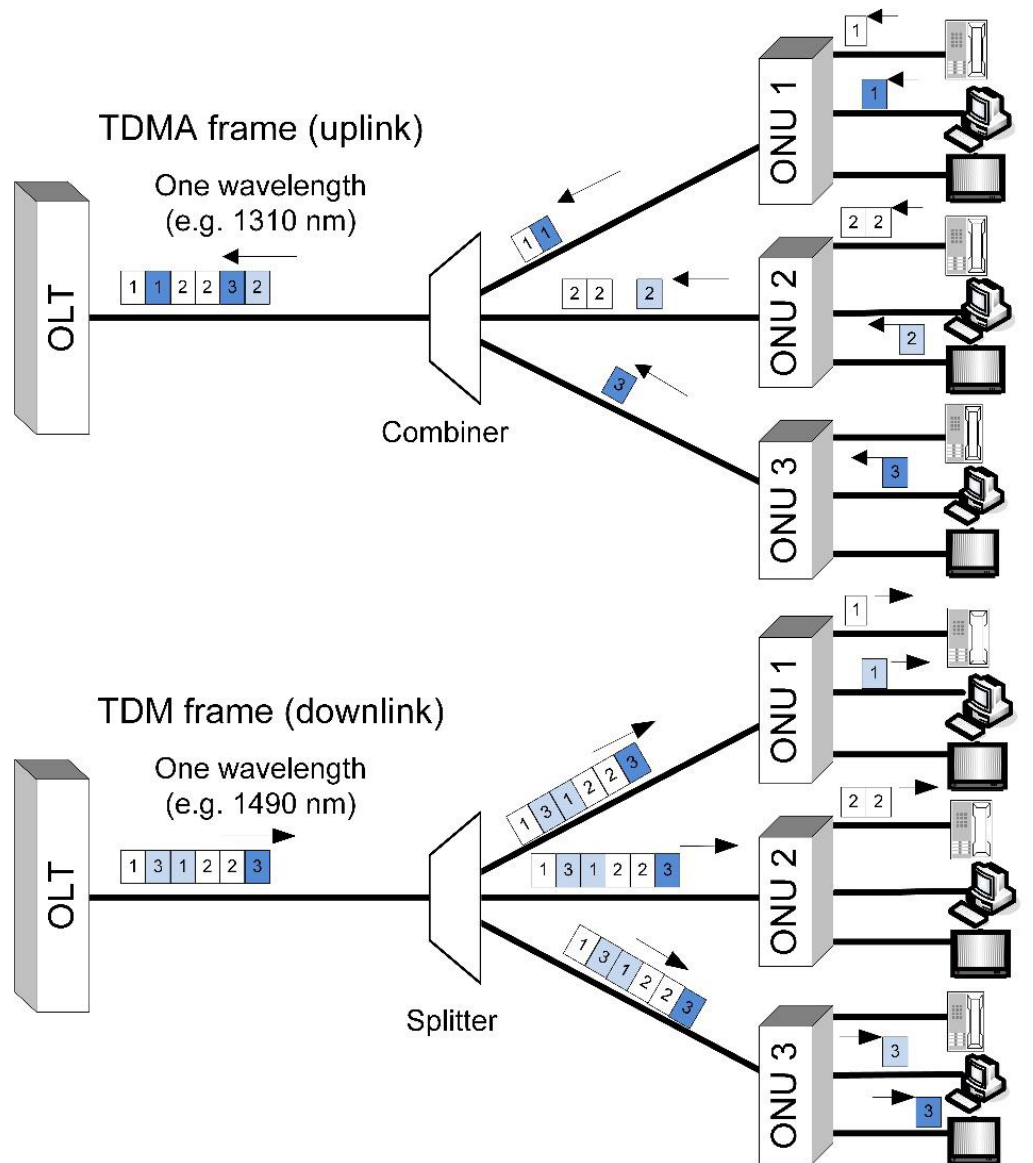
Figure 6. The uplink and downlink frame of a TDM-PON. APON/BPON — ITU-T Rec. G.983.x: APON (ATM-PON) is the first PON which was standardized (1998) based on ATM (asynchronous transfer mode) technology because the